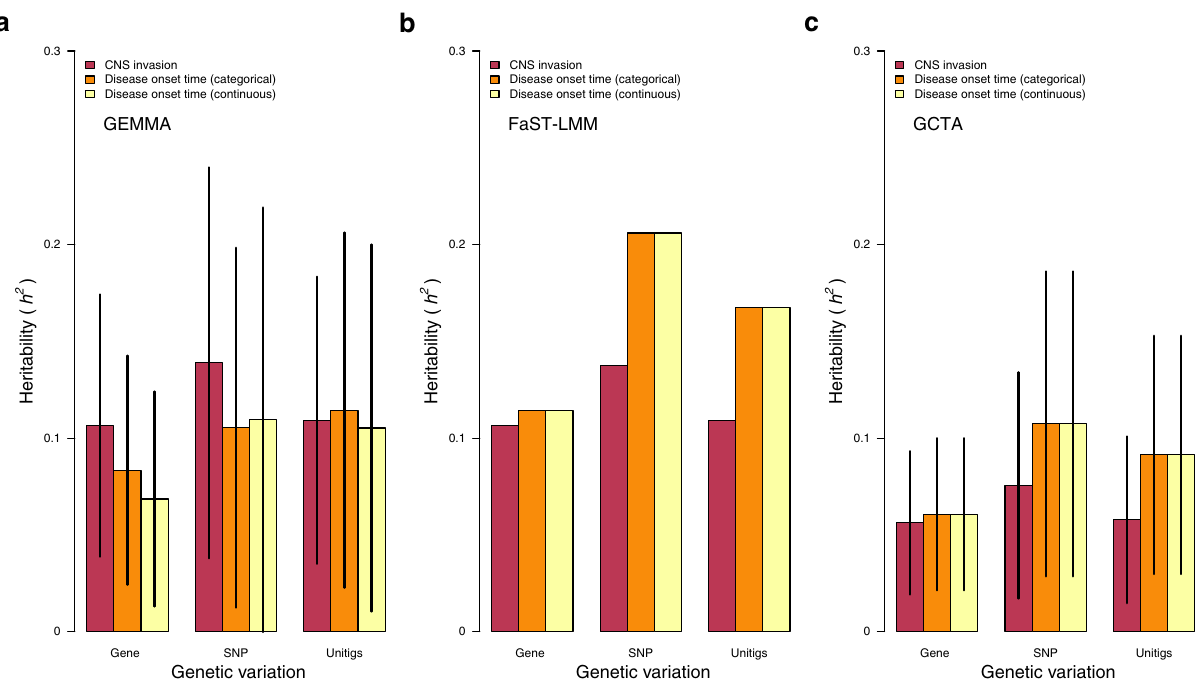
Fig. 6 Estimates of the narrow-sense heritability ( h 2 ) using different genetic variants and methods. a Heritability estimated for accessory genes, SNPs, and unitigs using GEMMA. b Heritability estimated for accessory genes, SNPs, and unitigs using FaST-LMM. c Heritability estimated for accessory genes, SNPs, and unitigs using GCTA. FaST-LMM reported no standard errors for the heritability estimates, therefore, we do not show the con fi dence intervals in the panel b . Heritability is expressed as a proportion with values ranging from 0 to 1. The error bars in each plot represents 95% con fi dence intervals. The estimates in panels a – c are based on n = 1338 isolates. Source data used to generate fi gures in panel a – c is available in Supplementary Data